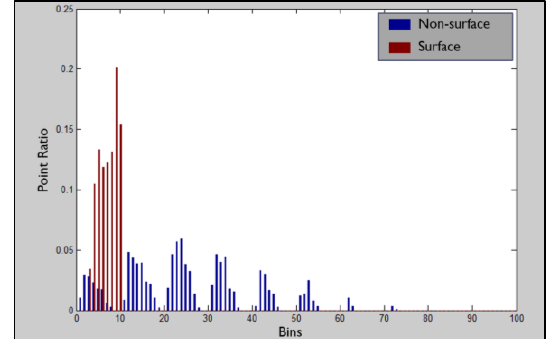
Figure 2. Examples of mean MLFH for training samples of the non-surface and surface classes. The horizontal axis is the bins in the feature space, while the vertical axis is the ratio of points in each bin to the number of points in the entire neighborhood.